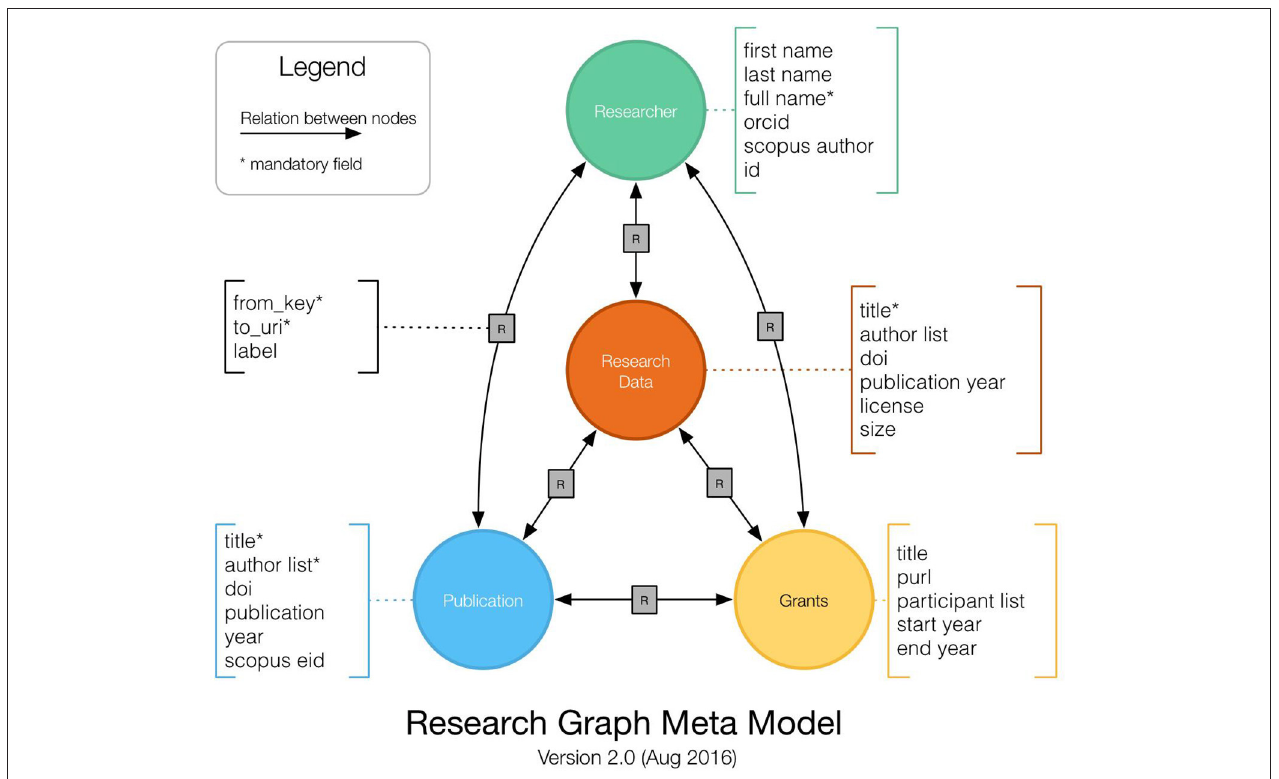
FIGURE 2 | The research graph meta model (Aryani et al., 2018).